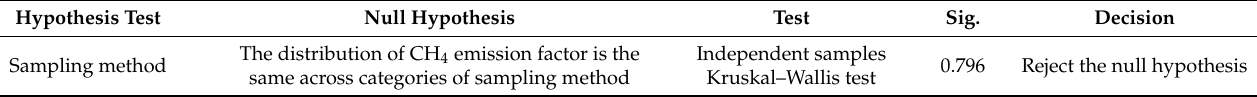
Table 9. The result of Kruskal–Wallis test by CH 4 emission factor about sampling method. Hypothesis